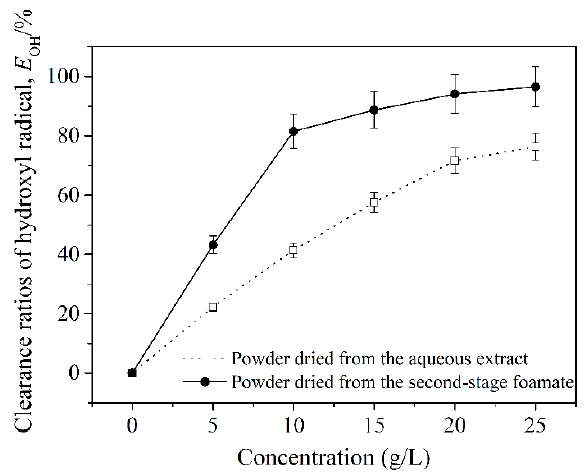
Figure 7. Variations of clearance ratio of hydroxyl radical with concentrations of powders dried from the aqueous extract of Semen Cassiae and the second-stage foamate.